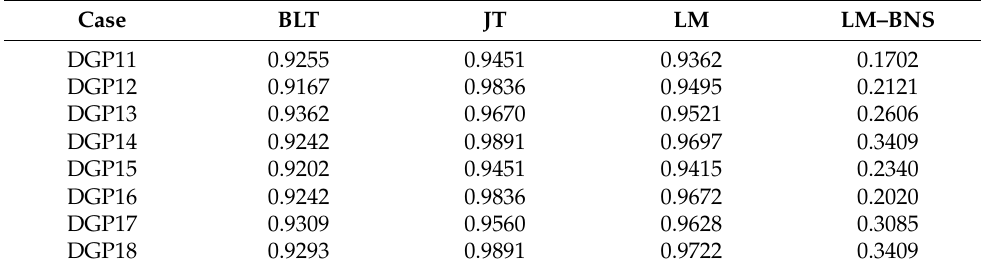
Table 5. Empirical power of co-jump tests under Monte Carlo simulations with co-jumps *.